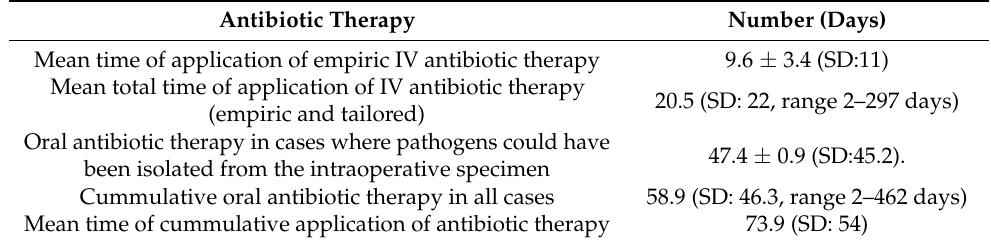
Table 6. Antibiotic